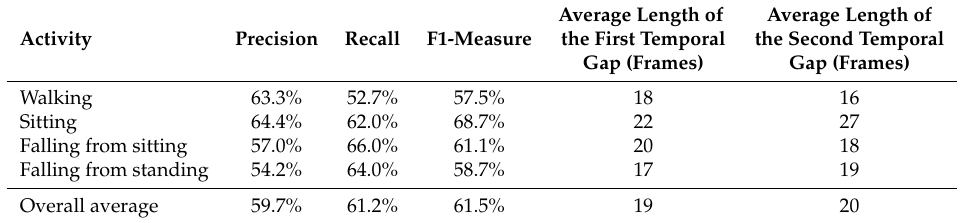
Table 7. Recognition results of the fall-related activities from partially-observed videos with missing video subsequences at the beginning (first temporal gap) and the end (second temporal gap) of the video sequences.